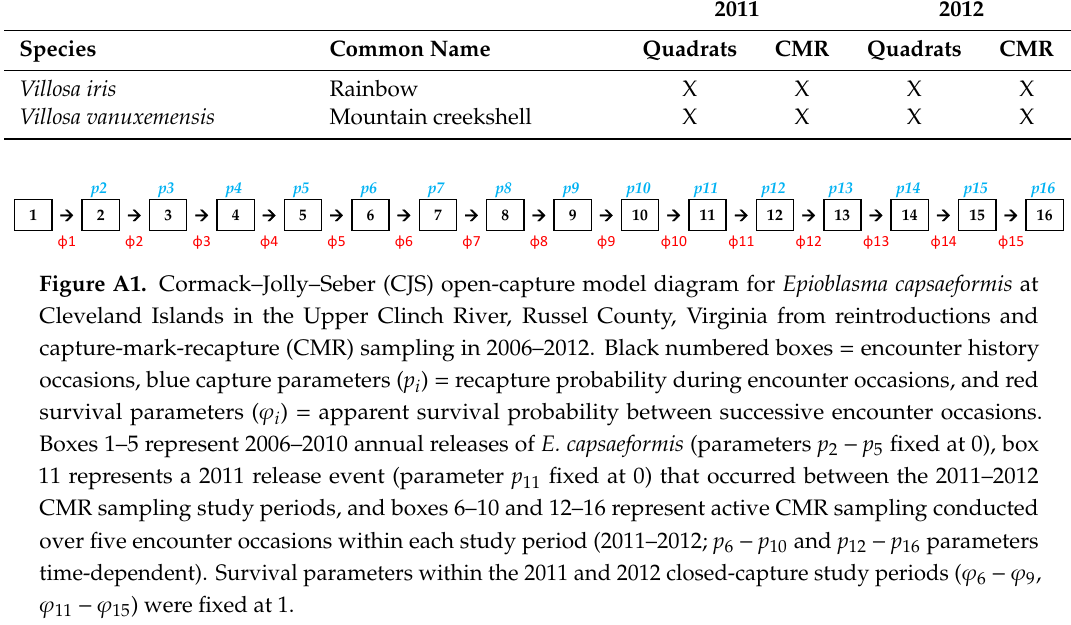
time-dependent). Survival parameters within the 2011 and 2012 closed-capture study periods ( ϕ 6 − ϕ 9 ,